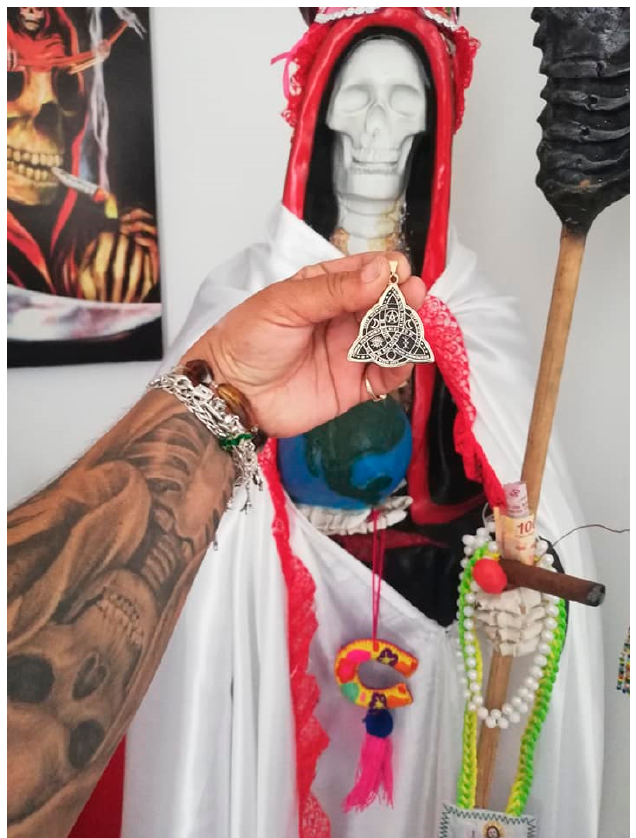
Figure 3. Yuri Mendez, founder of the largest shrine to Santa Muerte in Cancun using the Witches Knot to protect against negativity during a ritual to the folk saint of death. Note the offerings of money to Santa Muerte in her outstretched hand, and Yuri’s tattoo of Holy Death on her arm.